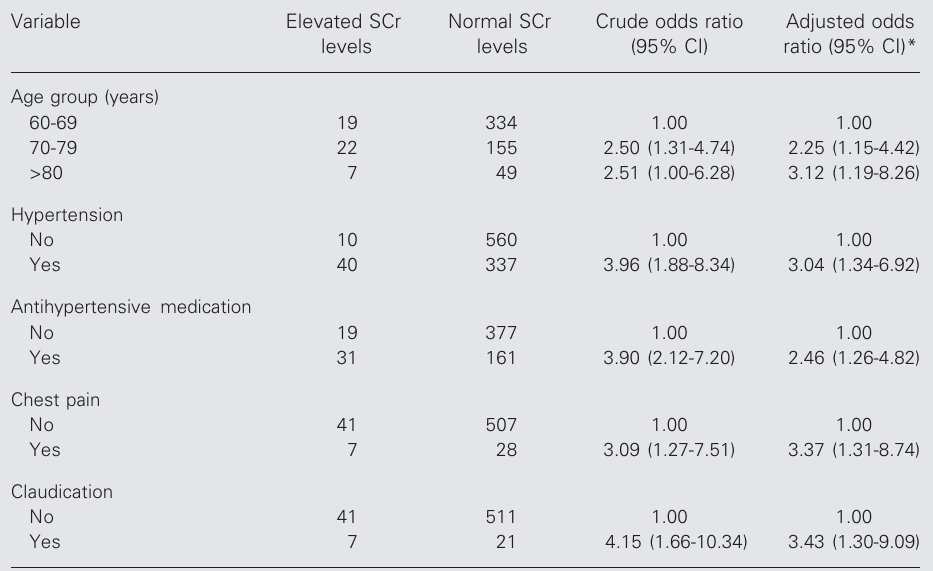
Table 3. Predictors of elevated serum creatinine (SCr) levels for men ( (cid:2) 1.3 mg/dl) in the multivariate analysis (Bambuí Health and Ageing